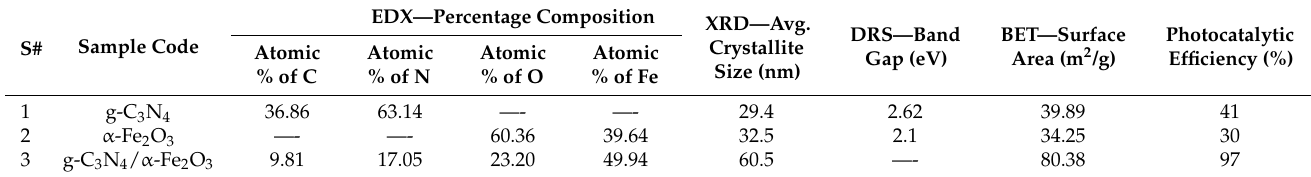
Table 1. Summary of all characterization